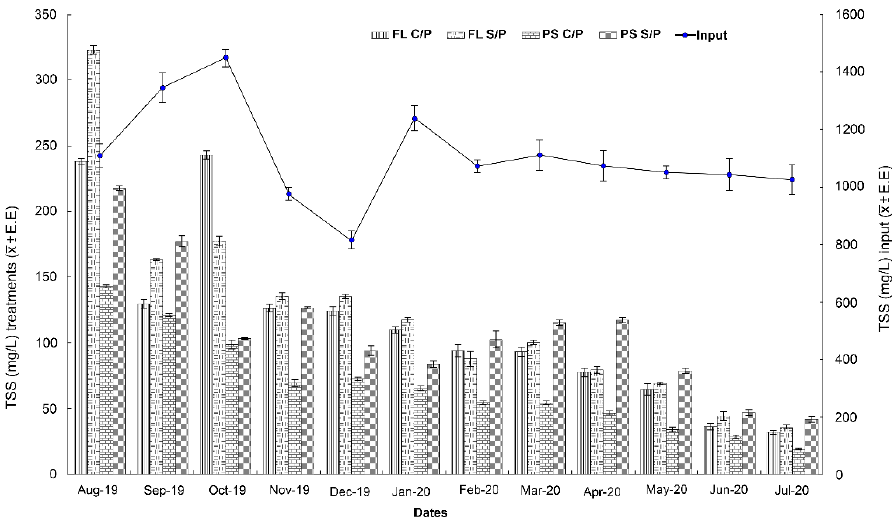
Figure 6. Average TSS ( ± E.E.) values obtained during the experiment. (FLCP: free flow with plant; FLSP: free flow without plant; PSCP: saturated flow with plant; PSSP: saturated flow with plant; E.E.: standard error).